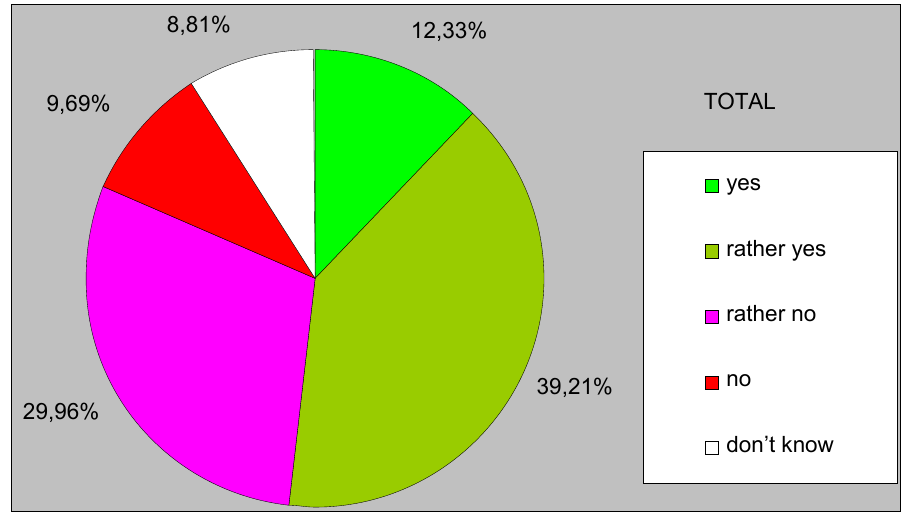
Fig. 3. Own evaluation of lifestyle in term of health by girls and boys (n=229)